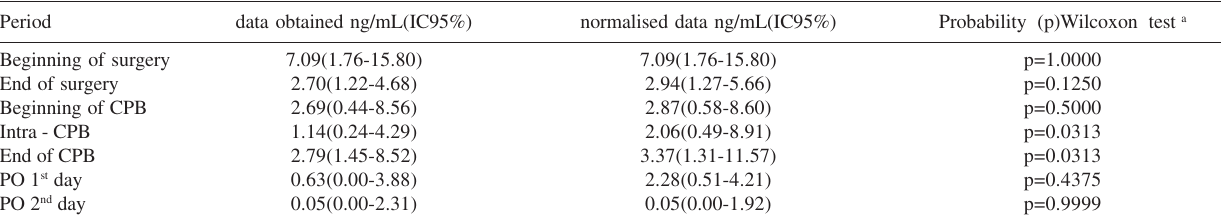
Table 5. Comparison of propranolol plasma concentrations during the surgery in patients with tetralogy of Fallot, medians, n=6.